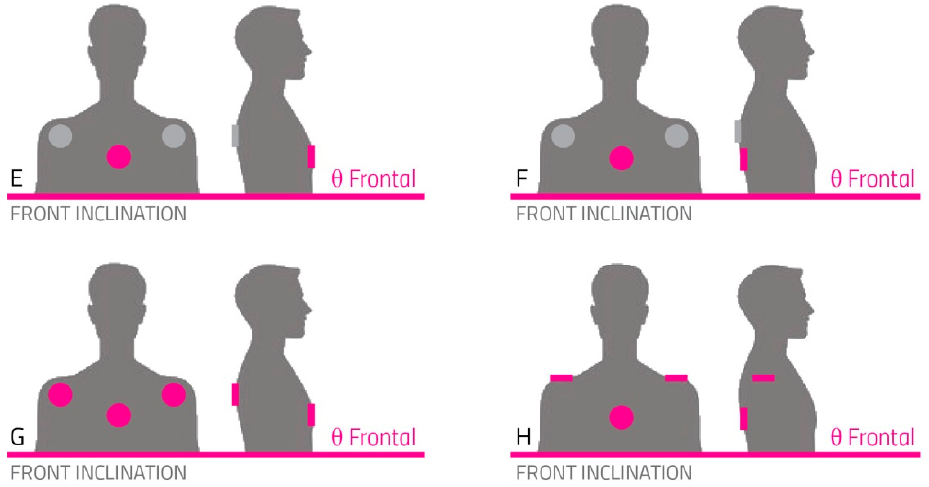
Figure 5. Actuator/SW positioning for the correction of frontal inclination.